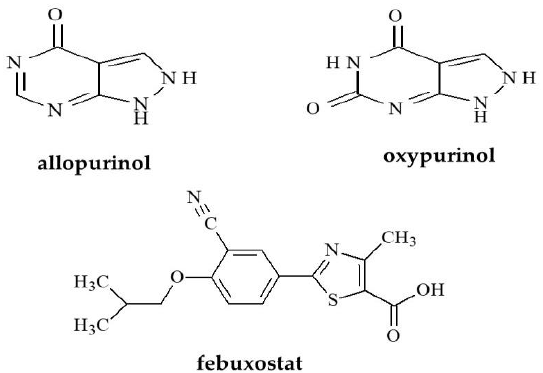
Figure 1. Chemical structures of studied compounds that lower blood uric acid.